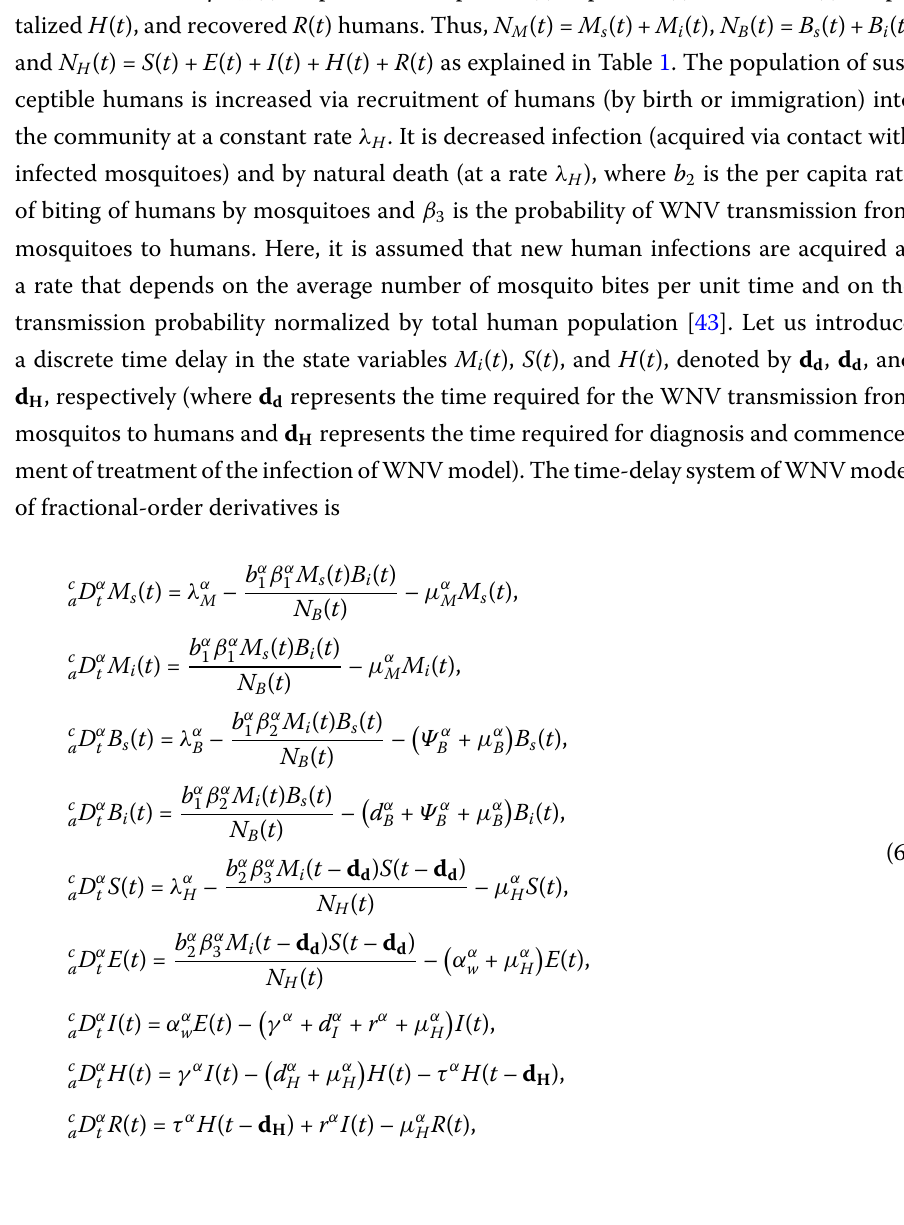
Table 1 All variables in system (6) and their definitions Variable Definition M s ( t ) The population of susceptible mosquitoes M i ( t ) The population of infected mosquitoes N M ( t ) The total population of mosquitoes N M ( t ) = M s ( t ) + M i ( t ) B s ( t ) The population of susceptible birds B i ( t ) The population of infected birds N The total population of birds N B ( t ) = B s ( t ) + B i ( t ) S ( t ) The population of susceptible humans E ( t ) The population of exposed humans I ( t ) The population of infected humans H ( t ) The population of hospitalized humans R ( t ) The population of recovered humans N H ( t